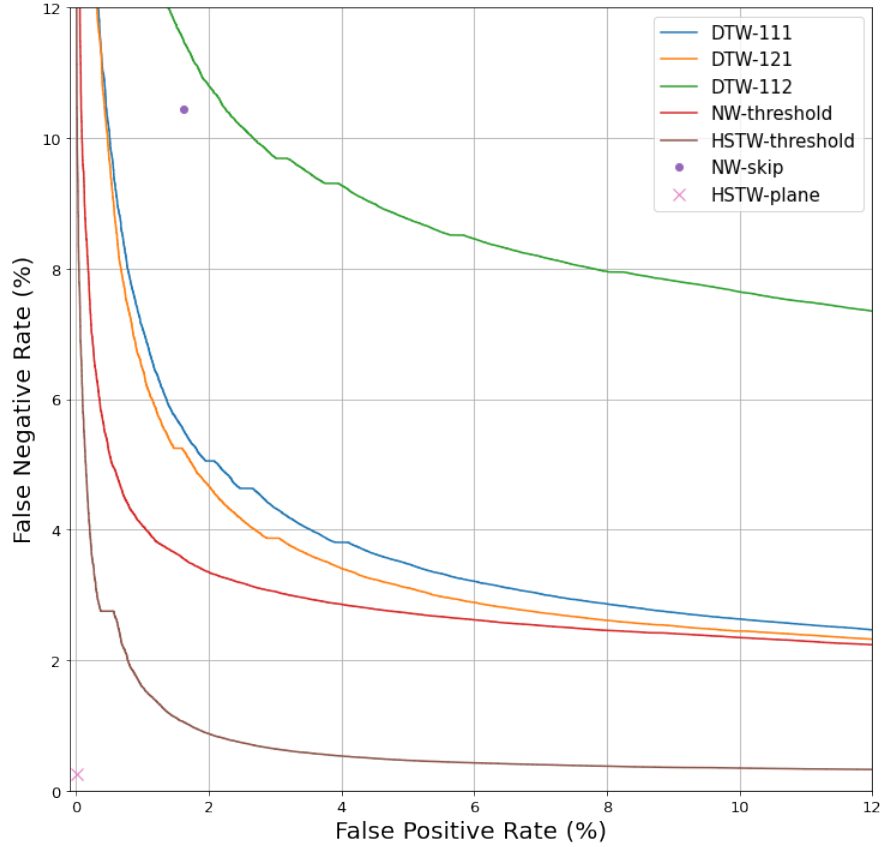
Figure 3. ROC curves for all systems on the speech alignment & verification task with a L = 2 s tam- pering duration. NW-skip and HSTW-plane are not threshold-based systems, so their performance is characterized by a single